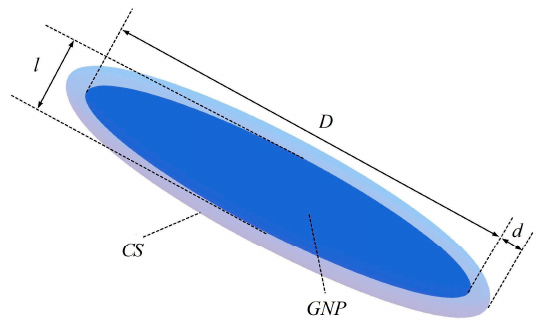
Figure 3. A coated surface (CS) on a GNP.